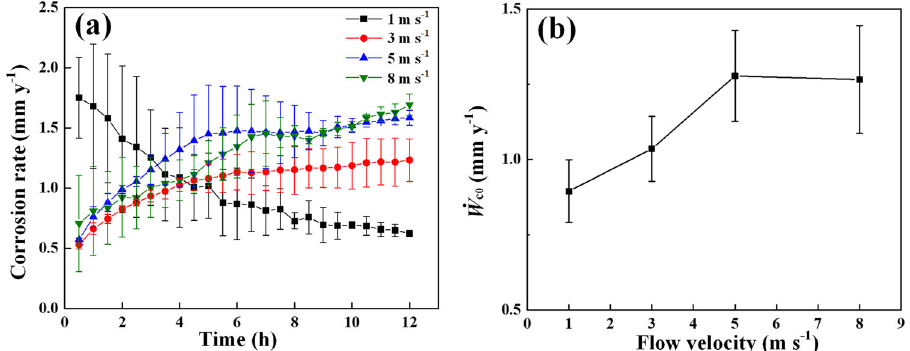
Fig. 1 Variation of corrosion rate in pure natural seawater. a Time dependence of the instant corrosion rates. b The general pure corrosion rate at different fl ow velocities. The error bars represent standard deviations of the three repeated tests at each fl ow velocity. Table 1. The EDS analysis of the local areas shown in Fig. 8. Flow